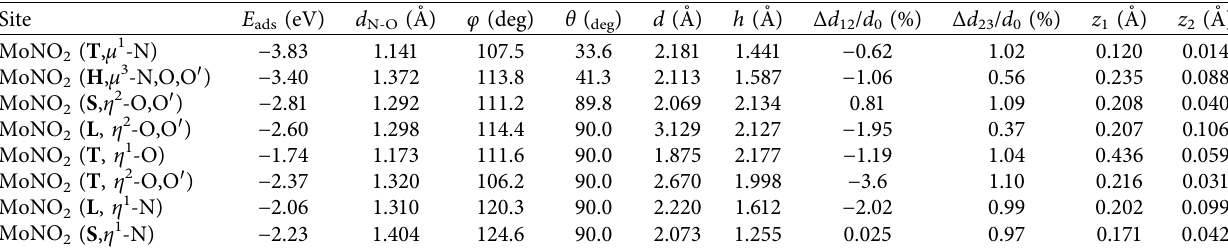
Table 5: Structural parameters of NO